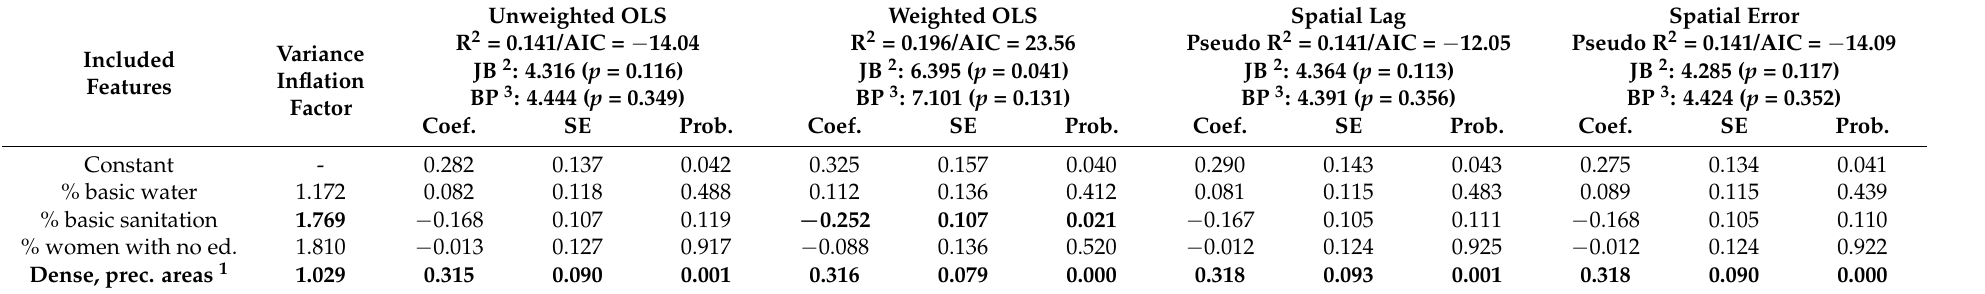
Table 4. Regression results of four models for the urban subset ( n = 105 spatial units), by model